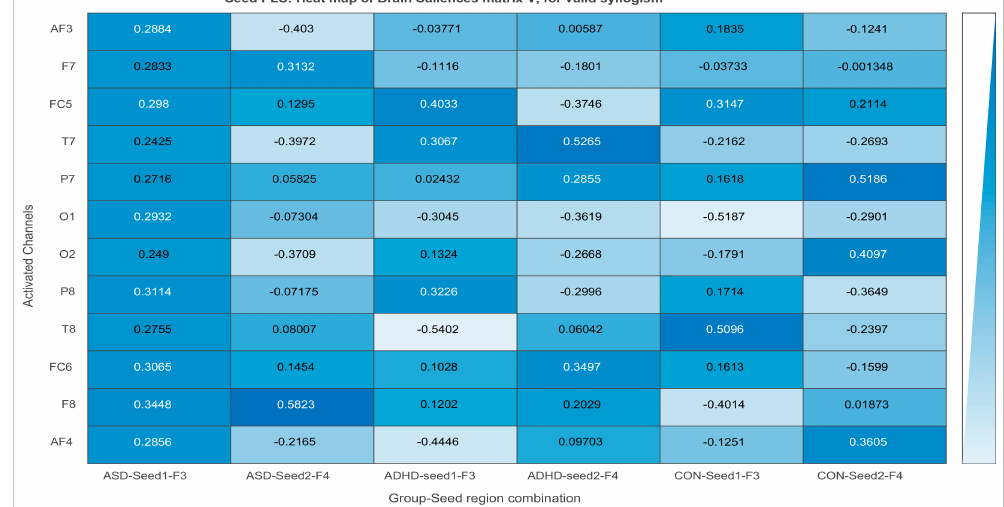
Figure 22. Heat map of the brain salience matrix V extracted by SVD of correlation matrix R between brain X and seed Y matrices, for the valid